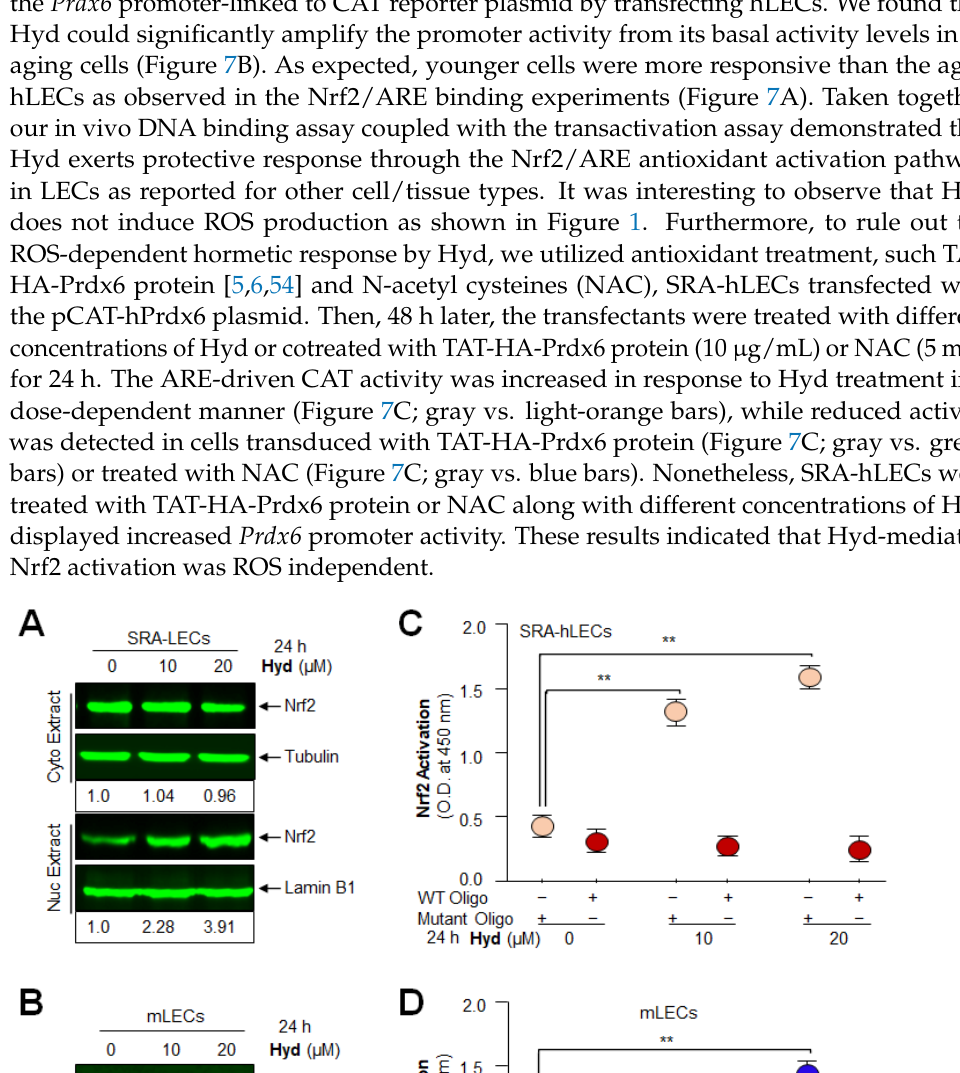
enrichment of Nrf2 on ARE sequences of the hPrdx6 gene promoter. Primary hLECs of variable ages treated with Hyd for 24 h were subjected to ChIP assay with antibody spe- cific to Nrf2. As shown in Figure 7A, the Nrf2 enrichment at ARE sequences in Prdx6 pro- moter was significantly increased in Hyd-treated, aging primary hLECs. However, younger hLECs were relatively more responsive to Hyd treatment compared to aging hLECs. This indicated that the aging hLECs retained Nrf2 activity and can be reactivated by means of Hyd treatment. Furthermore, to examine whether Hyd-induced increased Nrf2 binding to the Prdx6 promoter was functional, we carried out transcription assay with the Prdx6 promoter-linked to CAT reporter plasmid by transfecting hLECs. We found that Hyd could significantly amplify the promoter activity from its basal activity levels in all aging cells (Figure 7B). As expected, younger cells were more responsive than the aged hLECs as observed in the Nrf2/ARE binding experiments (Figure 7A). Taken together, our in vivo DNA binding assay coupled with the transactivation assay